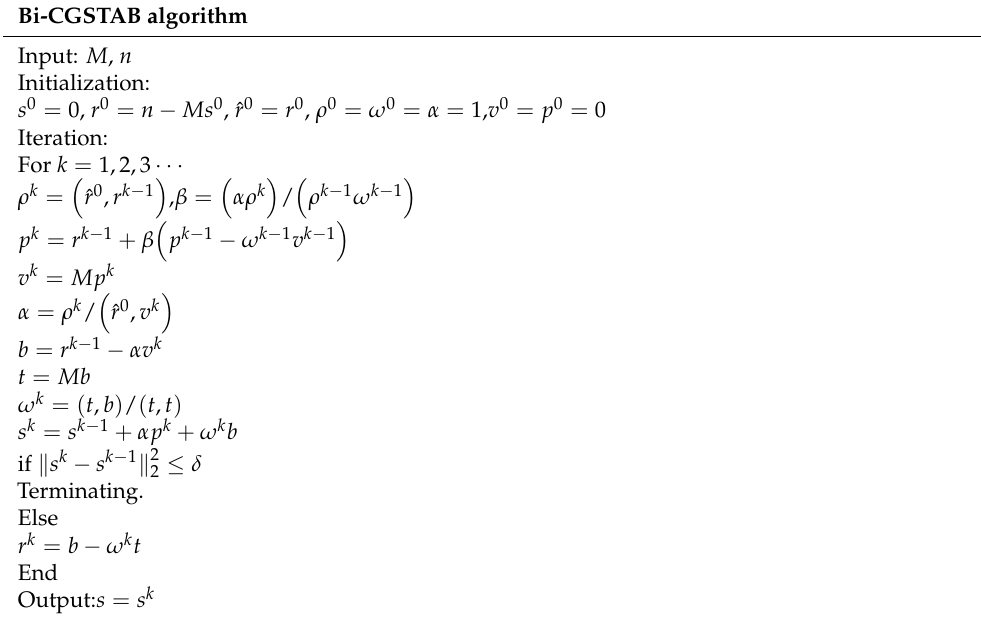
Algorithm 1. Pseudocode of the Bi-CGSTAB algorithm. Bi-CGSTAB